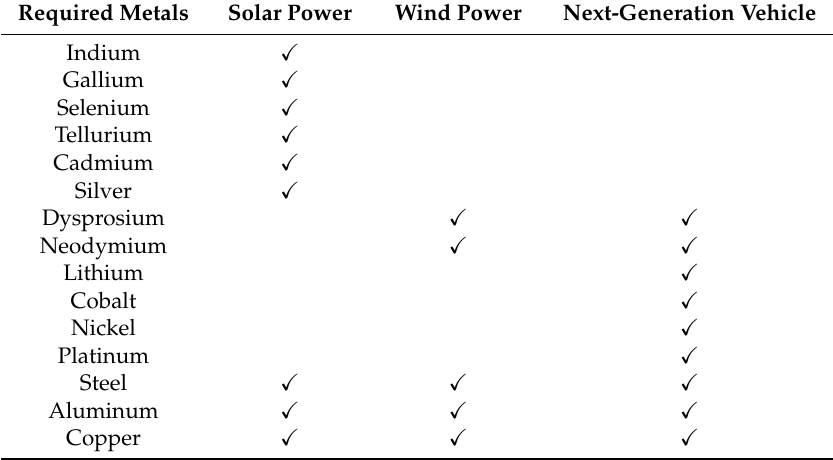
Table 1. Low carbon energy technology and required